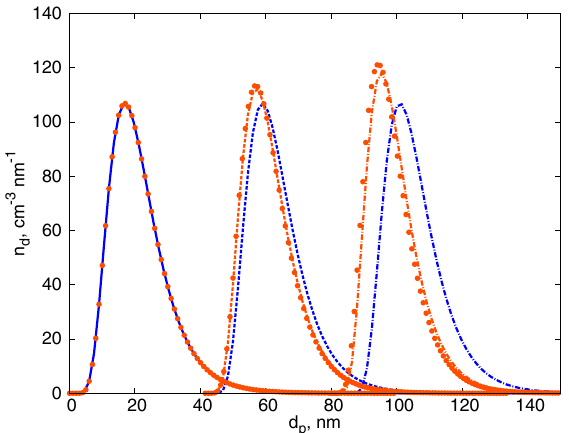
Figure 2. Time evolution of the lognormal aerosol distribution: blue – solution (9), the kinetic regime; orange – solution (10), the solu- tion for intermediate Kn . Solid curves – initial distribution; dashed curves – after 6h; dash-dotted curves – after 12h. Orange sym- bols display the numerical solution of the condensation equation employing the full FS